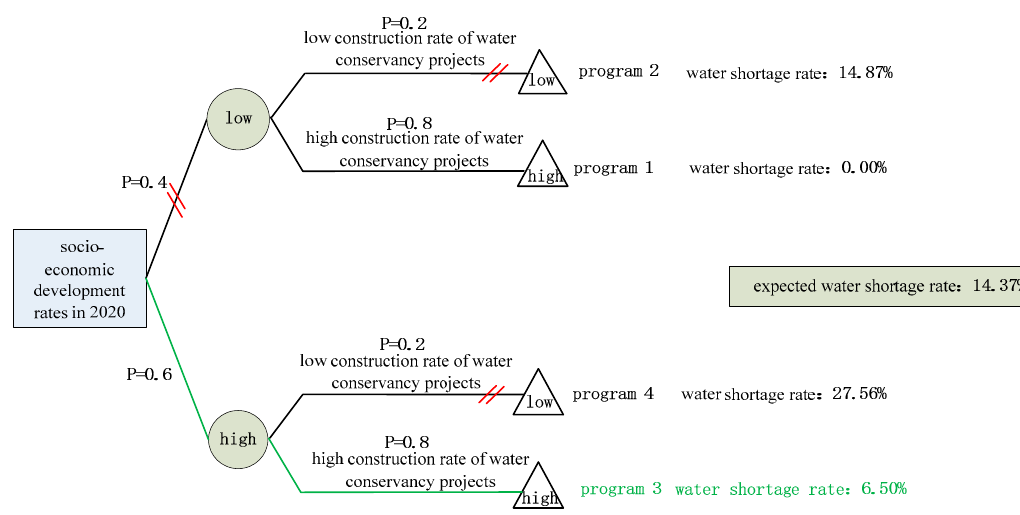
Figure 6. Decision tree method of socio-economic development and water conservancy projects construction for 2020.